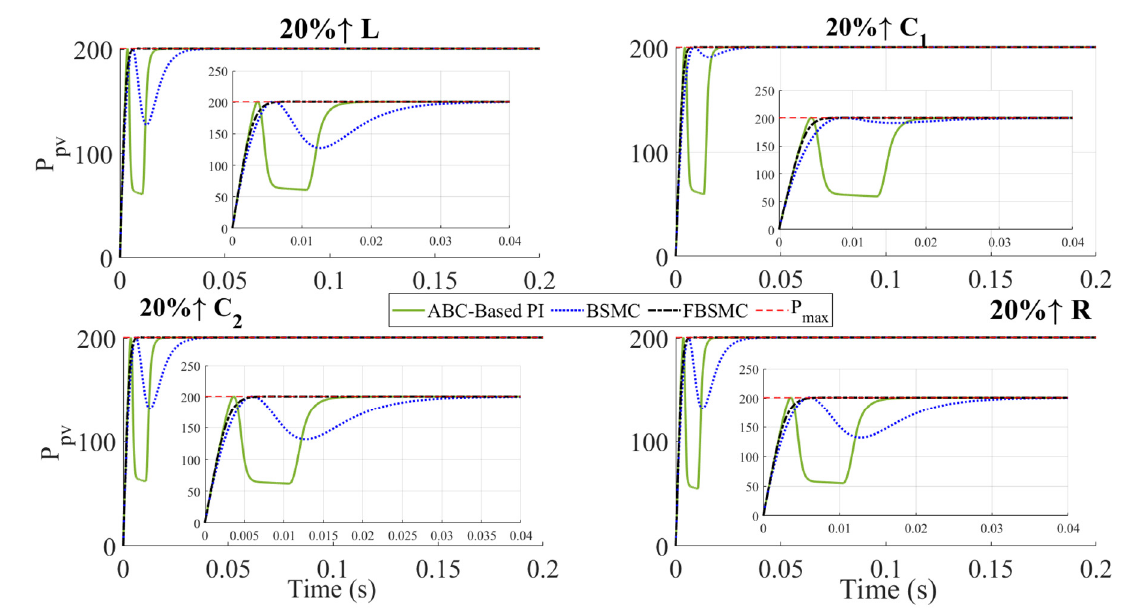
Figure 10. Extracted PV power for a 20% increase in the system parameters.